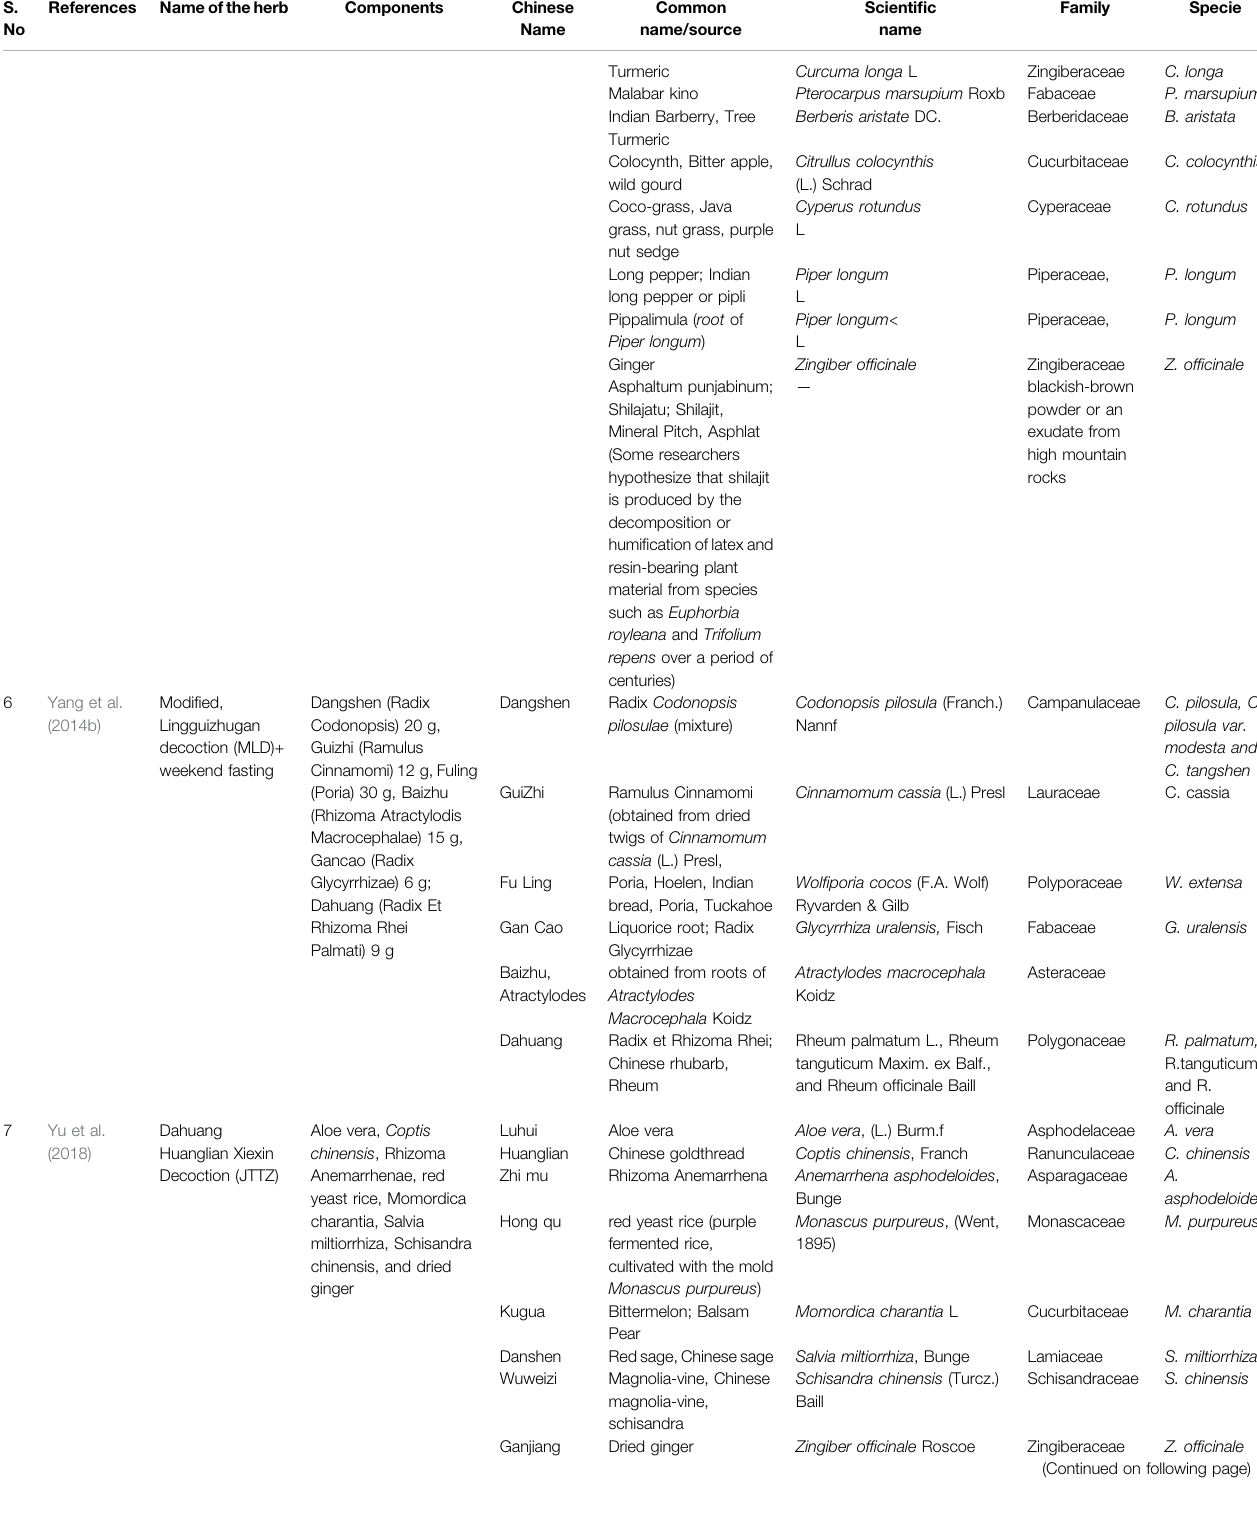
TABLE 2 | ( Continued ) Taxonomic classi fi cation of all the polyherbal combinations used in clinical studies against metabolic